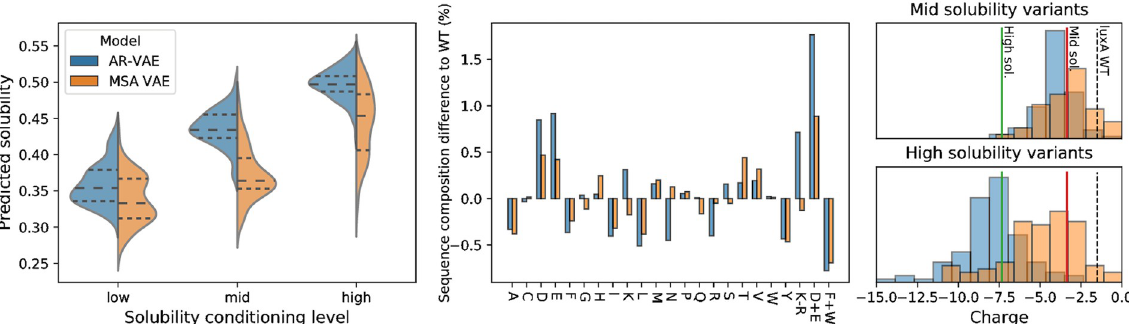
Fig 7. Computational analysis of variants generated by conditional VAE models conditioned on predicted solubility level. Left: distribution of predicted solubilities of sequences generated when conditioning on each of three solubility levels (median and upper and lower quartiles indicated with horizontal lines); centre: difference in amino acid composition percentages between generated variants at highest solubility level and original P19839 luxA sequence, including values for combined amino acid features used in protein-sol prediction algorithm; right: distribution of charge of luxA variants generated by conditioning on high (top) and medium (bottom) solubility levels. For comparison, the charge of the original P19839 luxA sequence is shown as a dashed line, the average charge for high solubility sequences in the training set is shown as a solid green line, and the average charge for medium solubility sequences in the training set is shown as a solid red line).